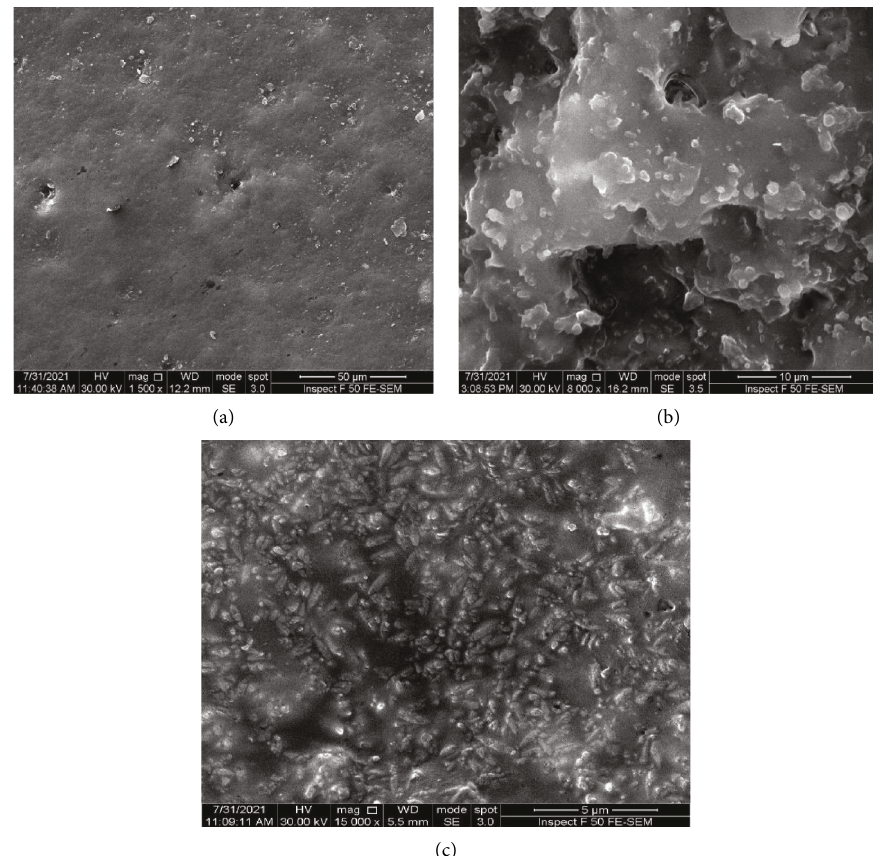
Figure 3: SEM images of (a) pristine bioepoxy, (b) bioepoxy/7wt% HA composite, and (c) bioepoxy/7wt% SS